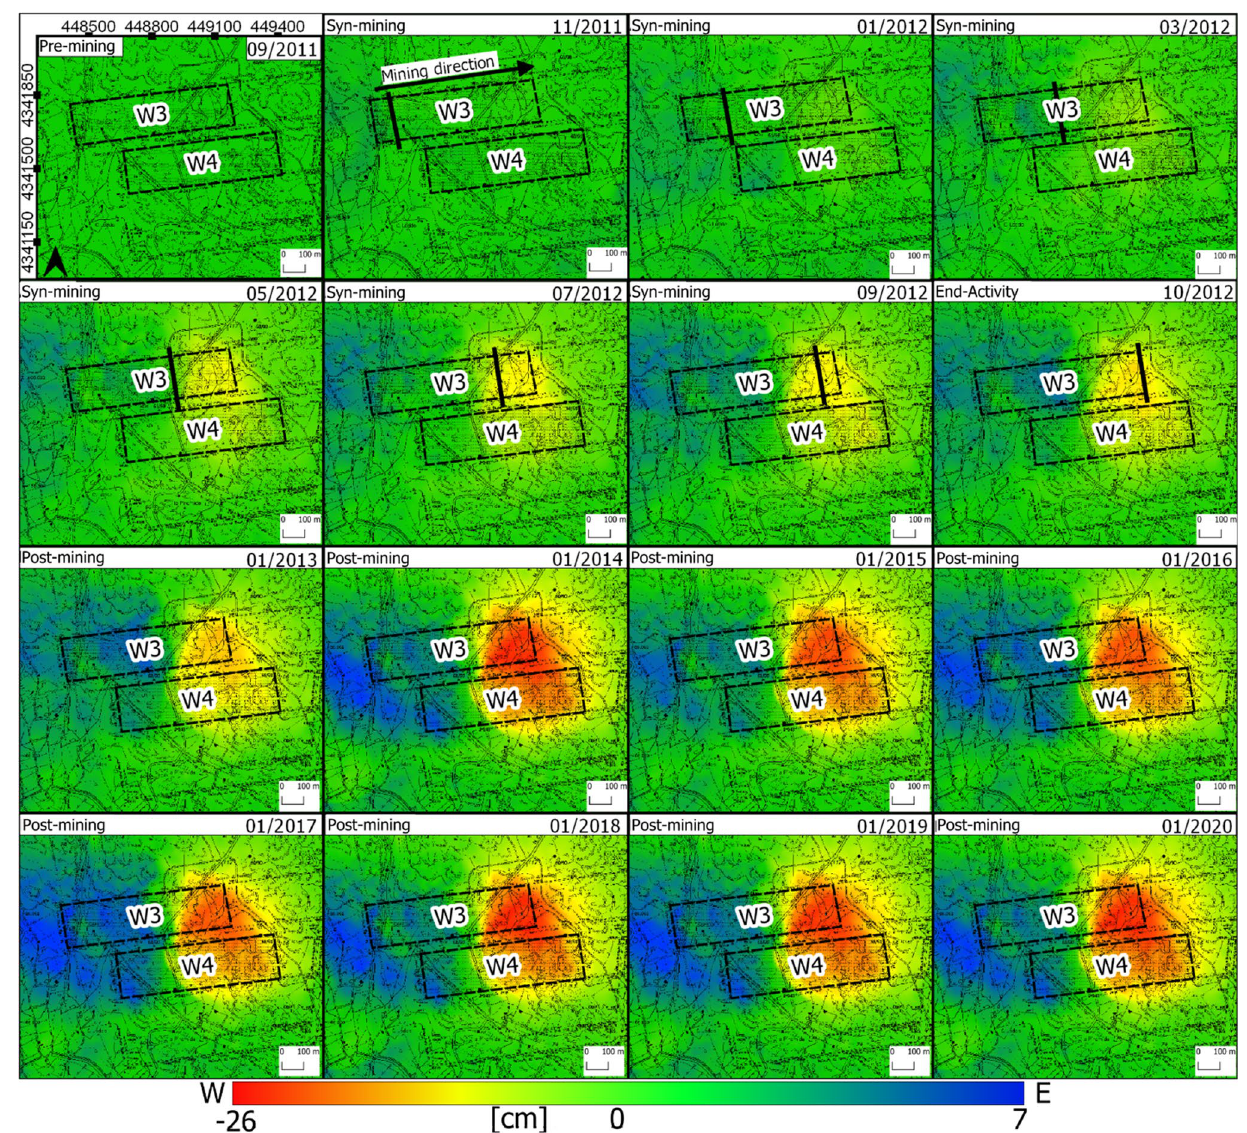
Fig. 9 Horizontal deformation maps pre-mining, syn-mining, and post-mining activity. Black dashed lines in the figure represent the mining